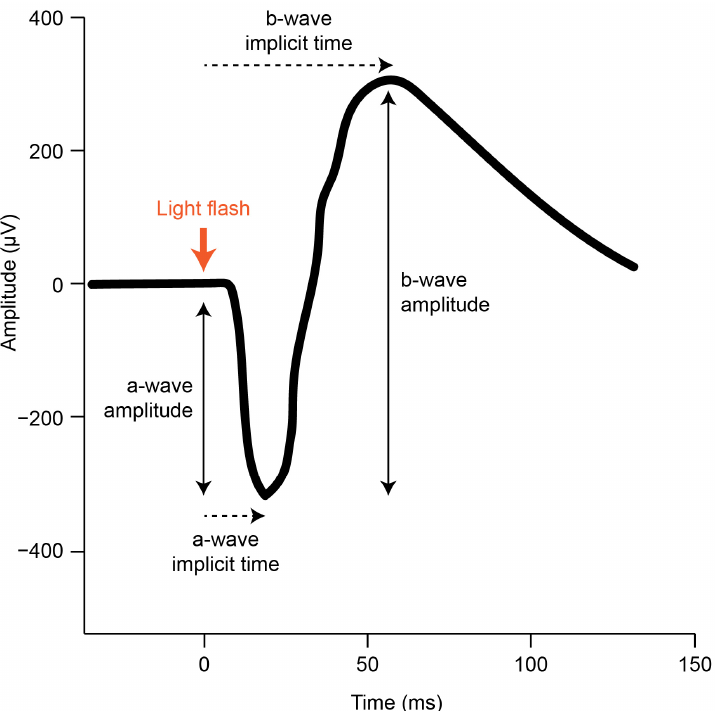
Figure 1. A typical scotopic gfERG initiated by a brief light flash (adapted from the ISCEV standard [31] ). The onset of the light flash is indicated (thick orange arrow) alongside the a-wave and b-wave amplitude and implicit time components that can be measured in the resulting retinal response.